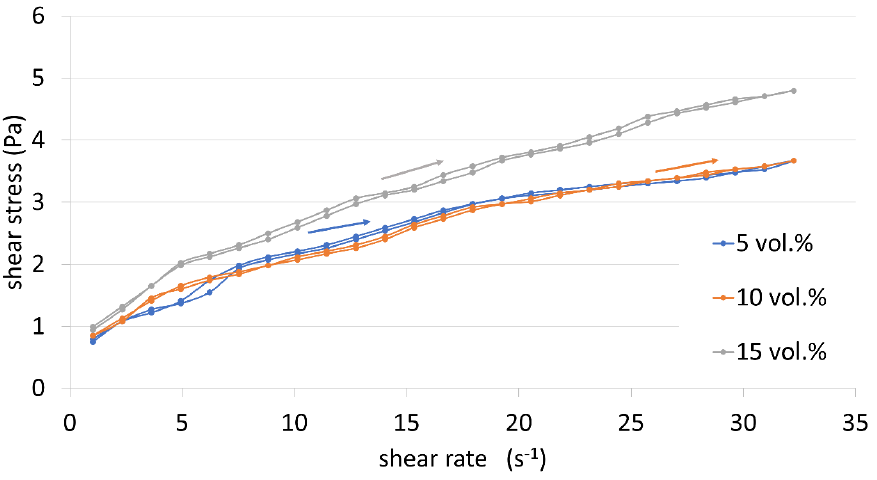
Figure 5. Suspension flow curves.